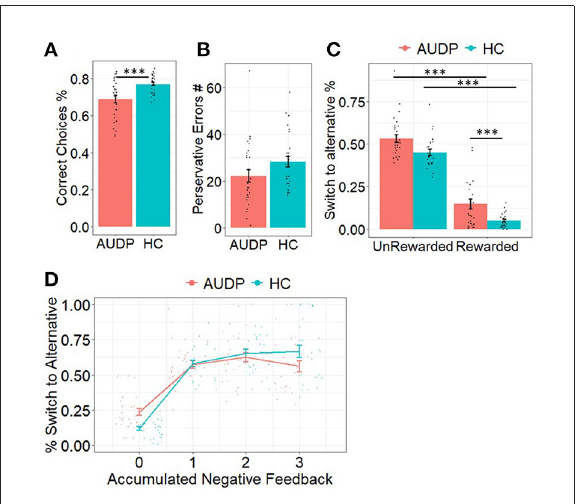
FIGURE2 Results of the choice analyses. (A) AUDP made significantly less correct responses. (B) Perseverative errors were similar between groups. (C) AUDP showed decreased win–stay behavior compared to HC. (D) AUDP showed increased switching behavior after no or limited negative feedback but decreased switching after multiple negative feedback compared to HC. *** p < 0.001.